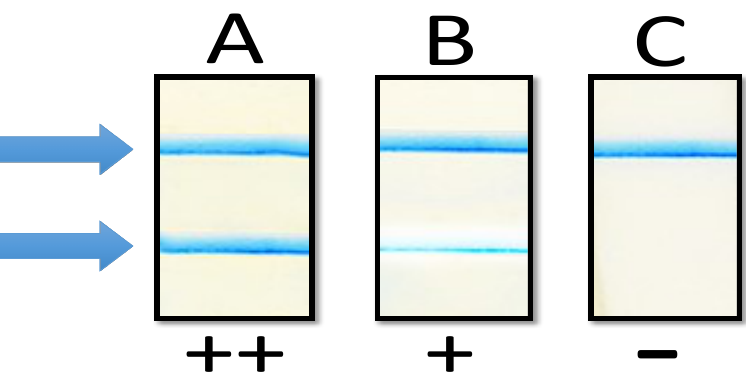
Figure 3. Example results of aMMP-8 point-of-care lateral flow immunotest. Two lines (indicated by arrows, ++, strong second line, lane A ) indicate elevated risk for periodontitis and alveolar bone loss; even a thin second (indicated by arrows, +, weak one, lane B ) line indicates elevated risk for periodontitis. One line indicates no risk for periodontitis (indicated by arrows, –, no second line, lane C ).